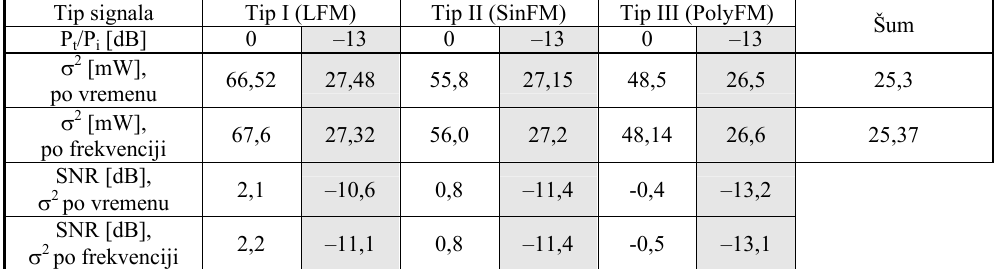
Srednjekvadratne vrednosti slu č ajnih procesa na ulazu u digitalni deo prijemnika i odgovaraju ć i odnosi